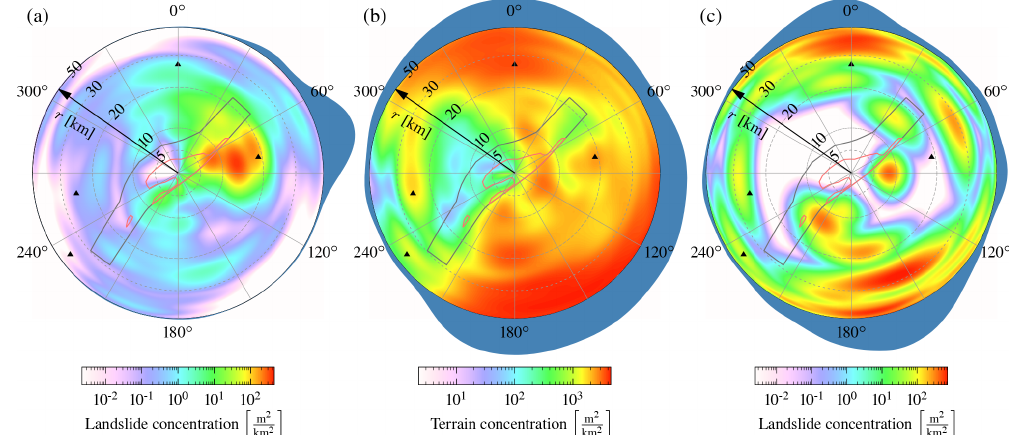
Figure 6. Kernel density estimates of azimuth and distance of (a) landslide concentration of the coseismic landslides, (b) concentration of landslide-susceptible terrain with hillslope inclinations > 19 ◦ , and (c) landslide concentration of unspecified landslides. Azimuth and distance are with respect to the asperity centroid. The marginal densities with respect to azimuth are shown in blue as outer ring. The densities are normalized to their maxima.